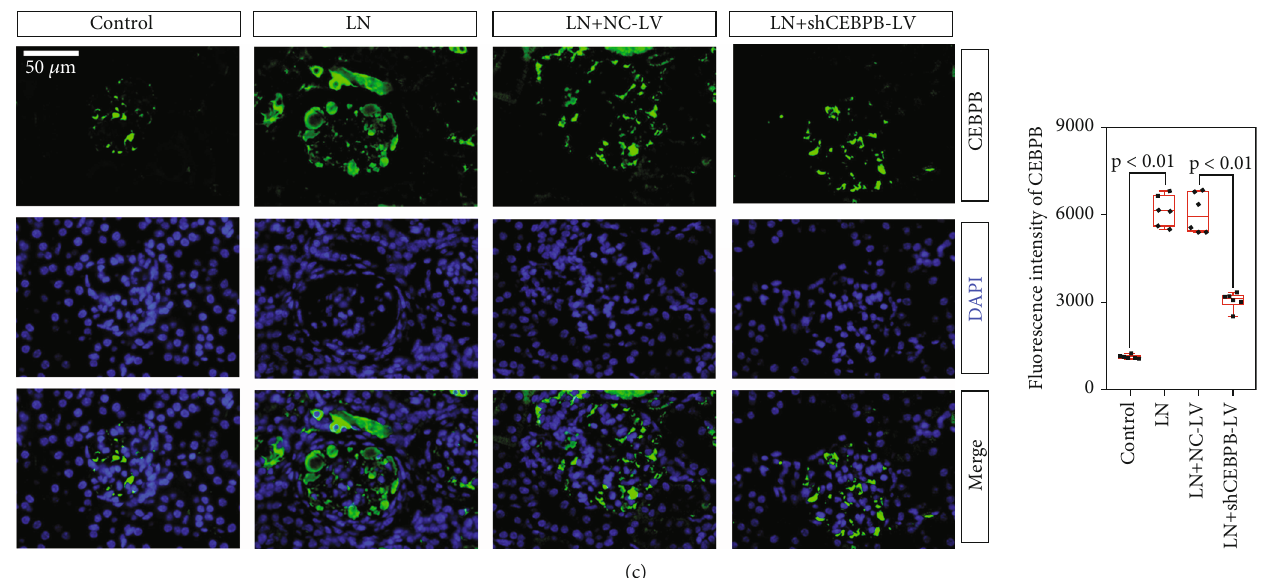
Figure 4: The knockdown of CEBPB inhibited the activation of NLRP3 in fl ammasomes in MRL/lpr mice. Relative expression of key proteins in the in fl ammasome-related signaling pathway in MRL/lpr mice after CEBPB downregulation (a); representative images of immuno fl uorescence detection of NLRP3 (b) and CEBPB (c) expression (50 μ m) in MRL/lpr mice with knockdown of CEBPB . (CEBPB, CCAAT/enhancer-binding protein β